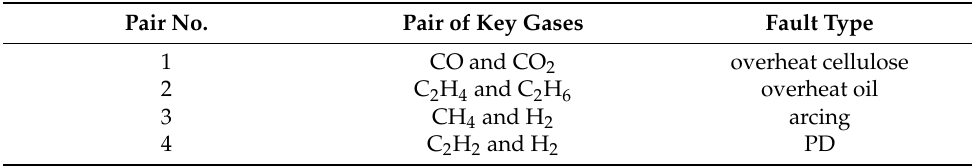
Table 2. Fault identification using the key gas method.